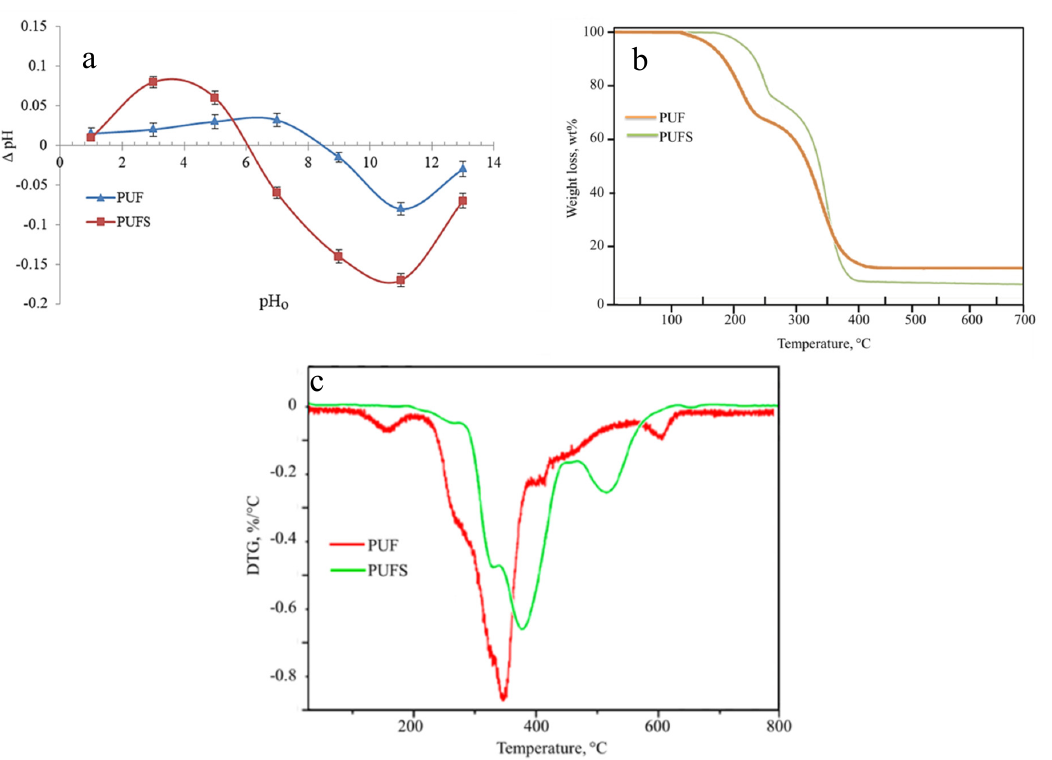
Figure 4. ( a ) pH ZPC of white PUF and PUFS, ( b ) TGA curves of white PUF and PUFS and ( c ) DTG curves of white PUF and PUFS.